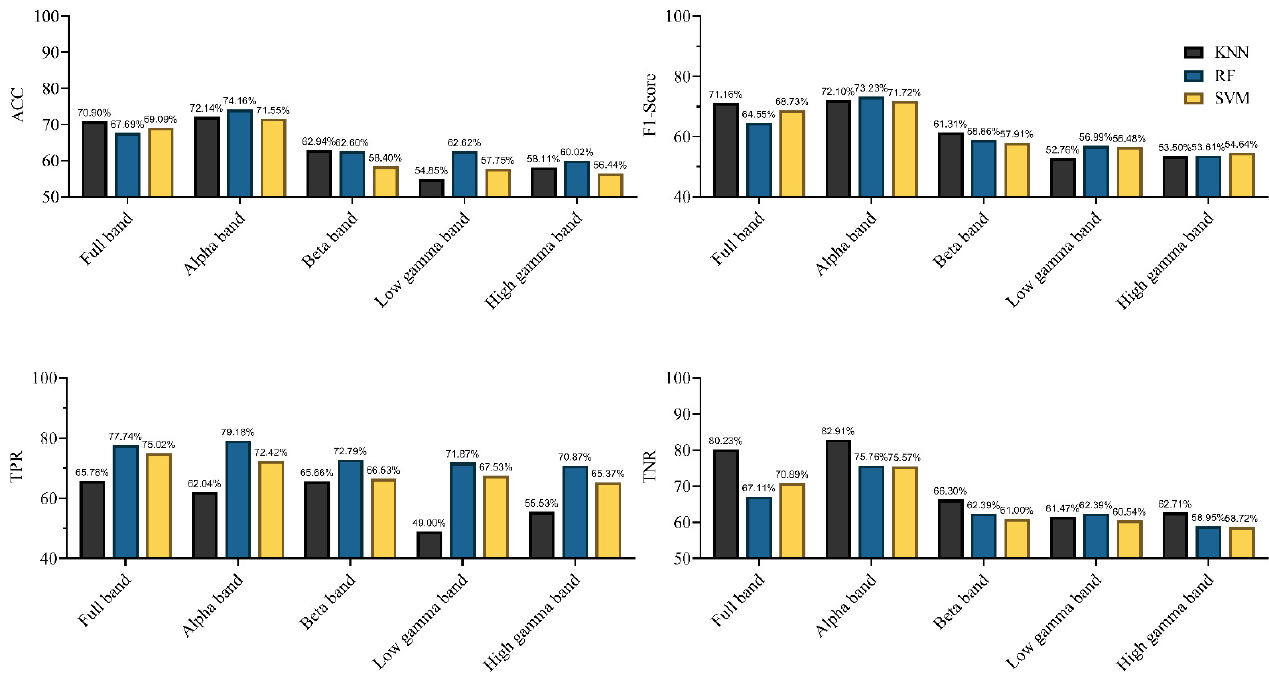
Figure 10. Performances of the different classifiers, characterized by EEG signals in different frequency bands (in terms of Accuracy (ACC), F1-score, true positive ratio (TPR), and true negative rate